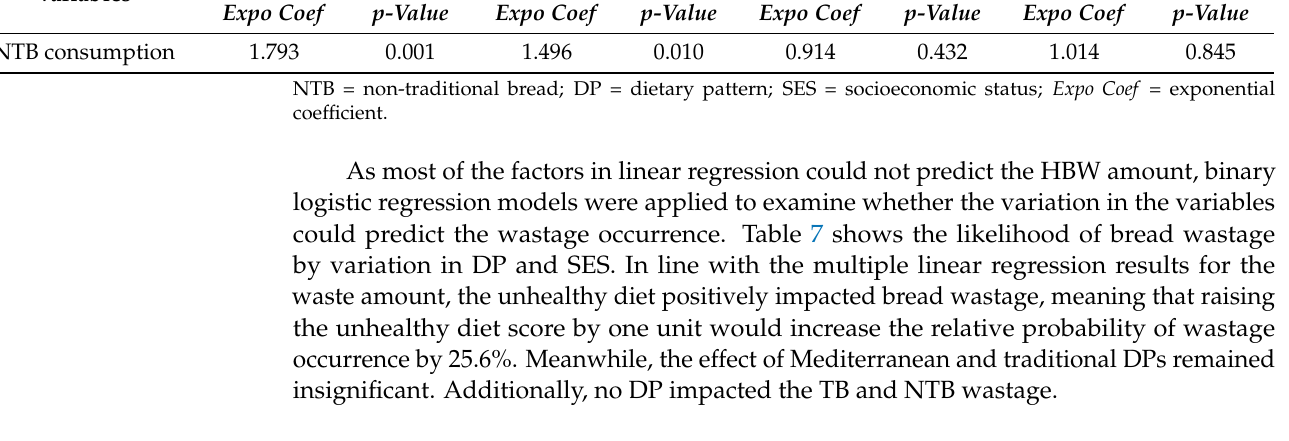
Table 7. Binary logistic regression weights and significances for predicting bread wastage